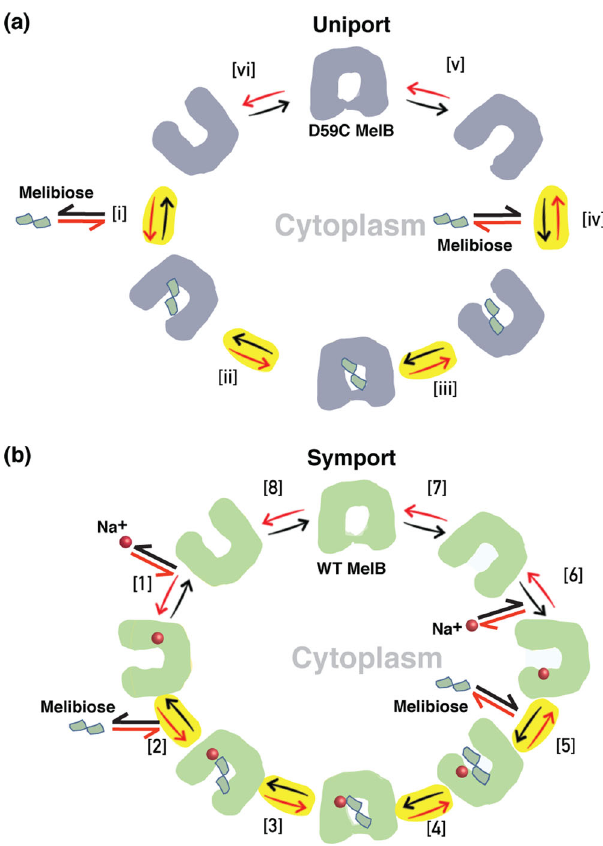
Fig. 6 Transport models for the symport and uniport catalyzed by MelB. The symbols for the WT and D59C MelB proteins, Na + , and melibiose are indicated. a Uniport catalyzed by the D59C MelB mutant. Melibiose inward-directly transport begins at step i and proceeds via the red arrows around the circle of 6 steps, with one melibiose across the membrane per circle. Melibiose ef fl ux transport begins at step iv and proceeds via the black arrows around the circle, with one melibiose across the membrane per circle. Melibiose exchange begins at step iv, and takes one intracellular melibiose in exchange with one extracellular melibiose molecule, only involved in step iv – i, a 4-step reaction as highlighted in yellow color. b Symport catalyzed by WT MelB. Melibiose active transport begins at step 1 and proceeds via the red arrows around the circle, with one melibiose and one cation inwardly across the membrane per circle. Melibiose ef fl ux transport begins at step 6 and proceeds via the black arrows around the circle, with one melibiose and one cation outwardly across the membrane per circle. Melibiose exchange begins at step 6, and also takes 4 steps involved step 5 - 2 as highlighted in yellow MalEFGK 2 58 , charged residues dictate the sugar binding, but it is not the case for the low-af fi nity maltose binding site within the membrane-domain in MalF 57 . Interestingly, an “ acceptor-donor- acceptor ” pattern for H-bonding with sugar is also found in MalE 58 .